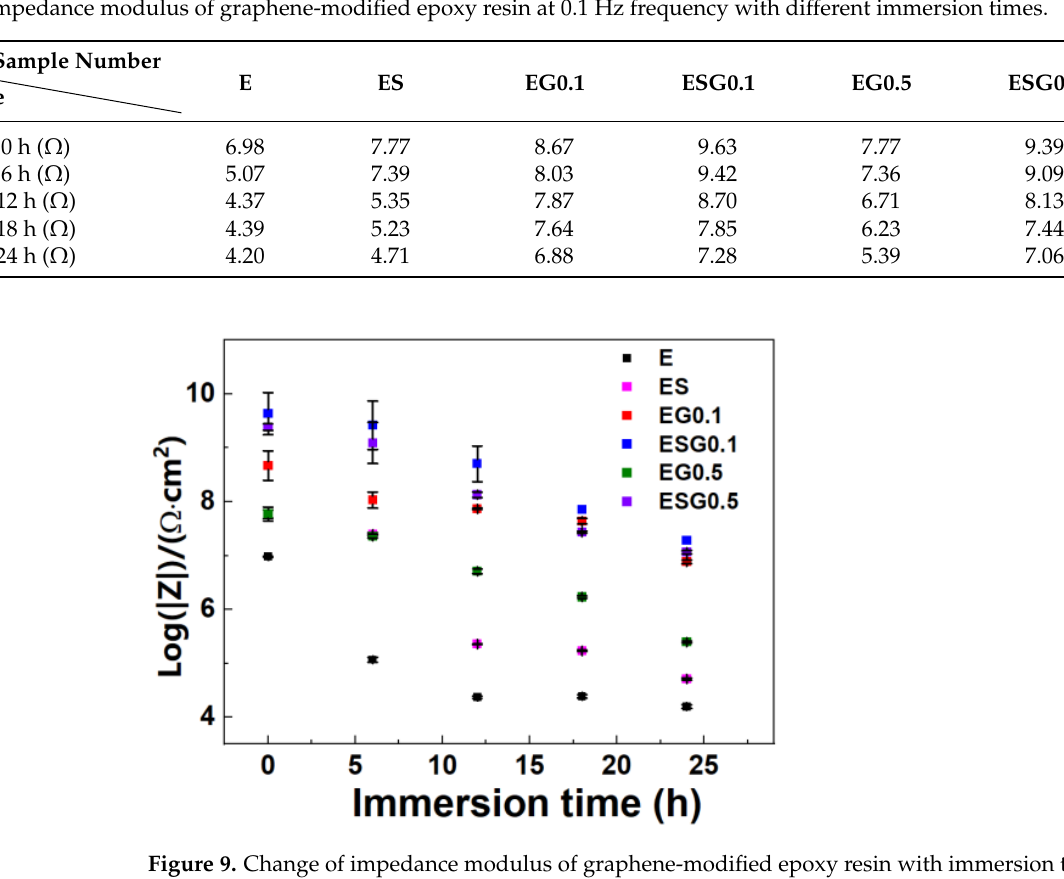
Figure 9. Change of impedance modulus of graphene-modified epoxy resin with immersion time at 0.1 Hz frequency.